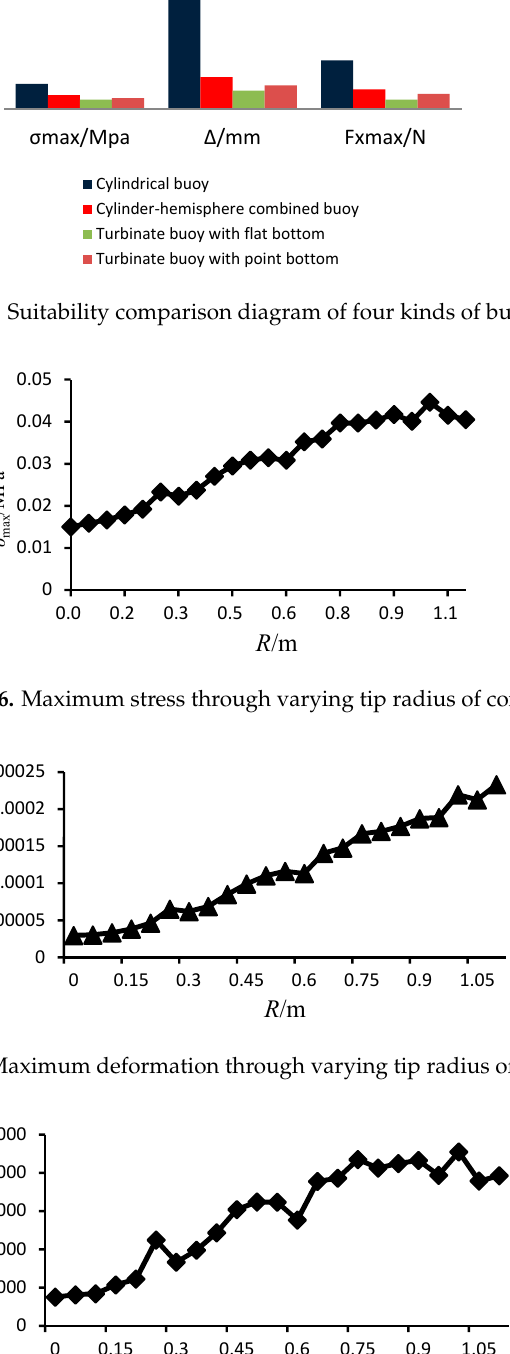
Figure 8. Maximum horizontal impact force through varying tip radius of cone.